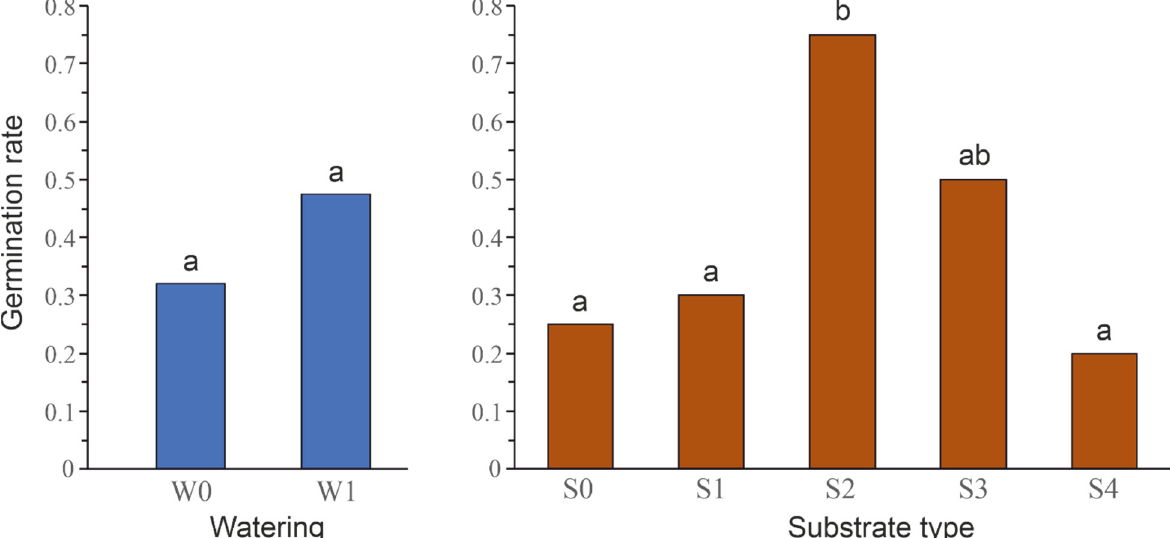
Figure 3. Independent distributions of the germination rate by level of watering treatment ( left ) and soil type ( right ). Different/shared letters correspond to significant/non ‐ significant differences.